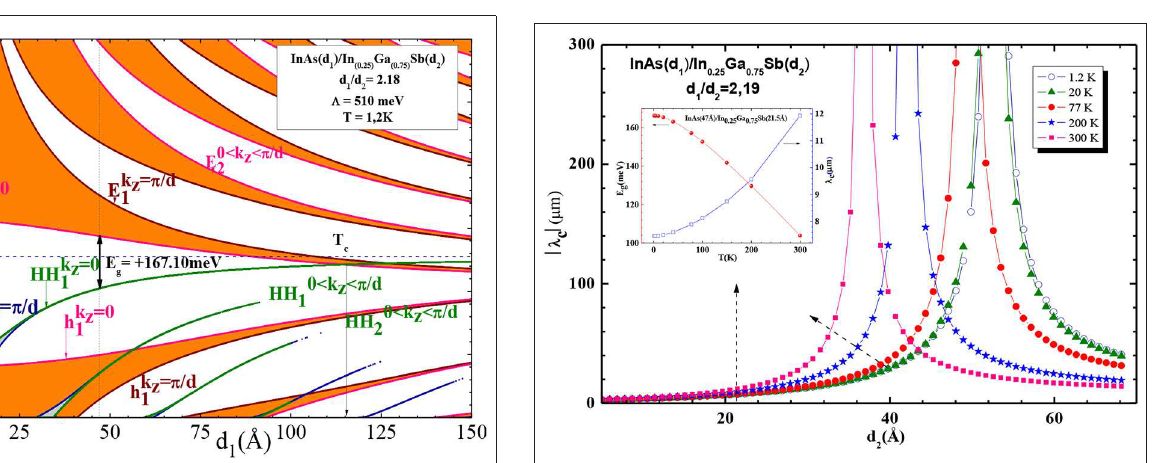
FIGURE 4 | SLs | λ c ( Ŵ )| as a function of d 2 for various temperatures. In the insert the variation of E g (T) and λ c (T) with temperature in the investigated SL.